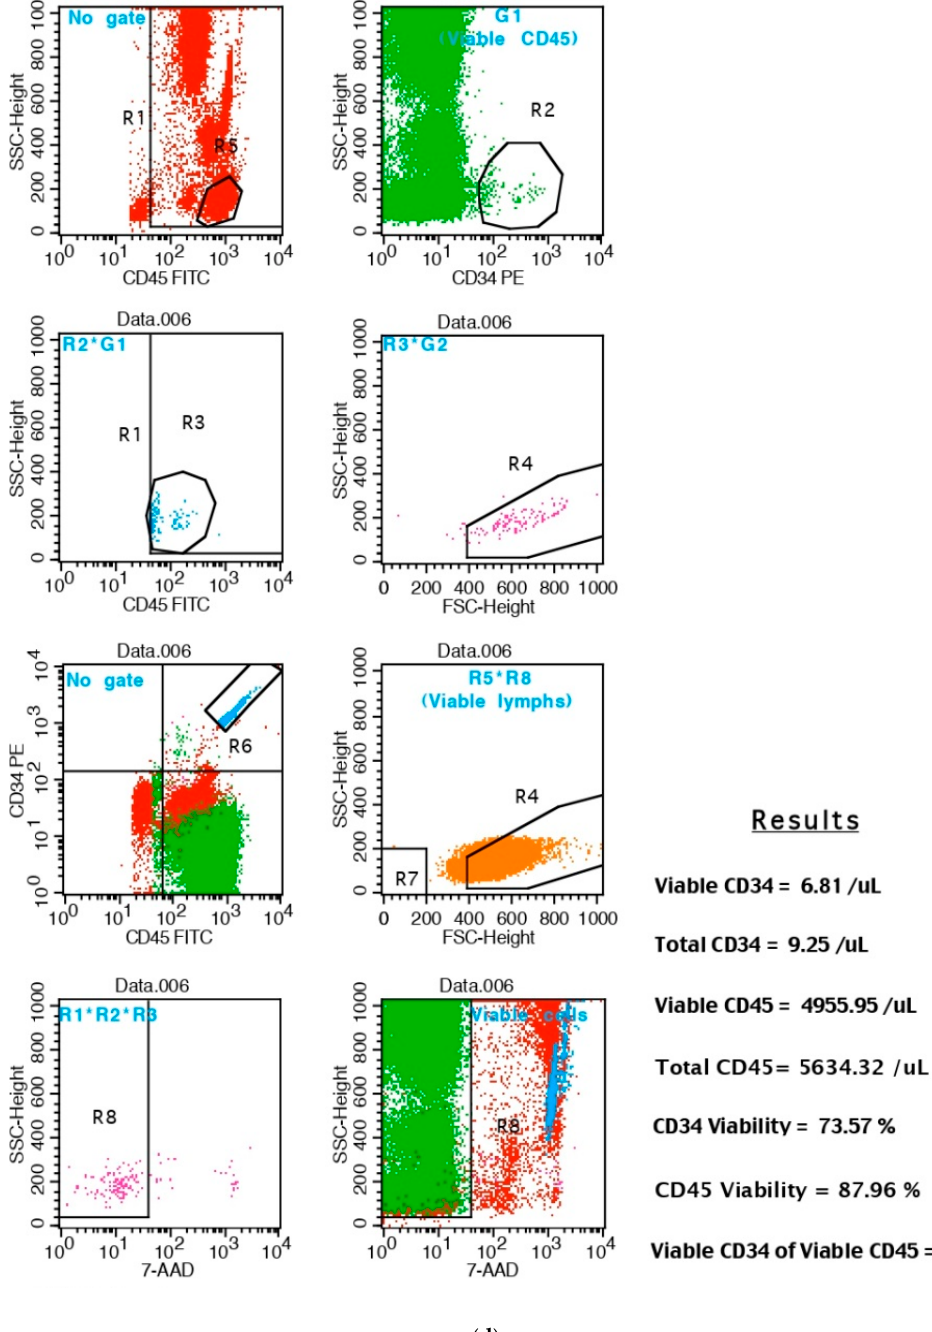
Figure 6. Representative flow cytometry for CD34+ peripheral cells (conts) in study groups. ( a ) Peripheral CD34+ cell (counts) in controls; ( b ) Peripheral CD34+ cells (counts): short-term AFA consumption over 48 consecutive hours; ( c ) Total number of peripheral CD34+ in subjects over 48 h of curcumin administration; ( d ) Effects of long-term nutritional supplementation on total number of CD34+ peripheral cells. Asterisks *are events of data (CD34+ cell counts) within defined regions (R and number) and gates (G and number) for flow cytometry analysis (BD FACSCalibur). The R1*R2*R3 are measured regions for total CD34+ cells (counts) by the BD CellQuest software.